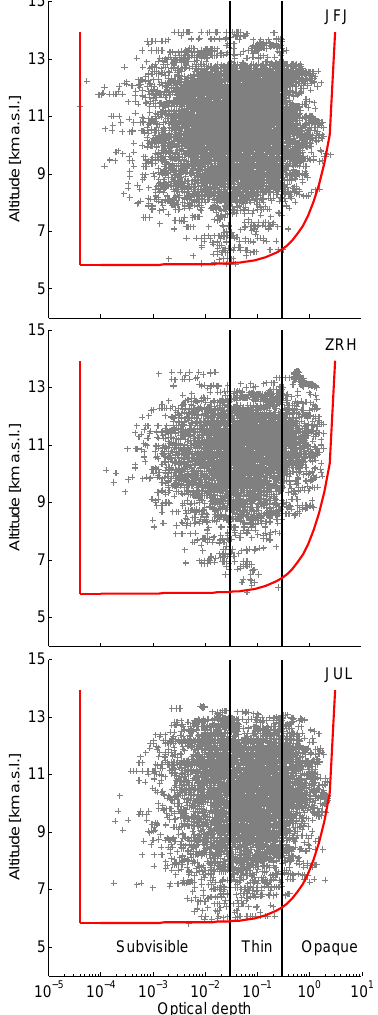
Figure 6. Scatter plots of cloud optical depths and cloud top al- titudes for the cirrus detected above Jungfraujoch (JFJ), Zürich (ZRH), and Jülich (JUL). The red lines provide an indication of the range of data accessible by the lidar measurements: AOD min = 4 × 10 − 5 , AOD max = 2 . 6, and Alt min = 5 . 8km. The lower edge of the accessible altitude is determined from T < − 38 ◦ C. Thicker clouds are more likely to extend into lower, warmer levels and there- fore are more likely to be excluded from the analysis.